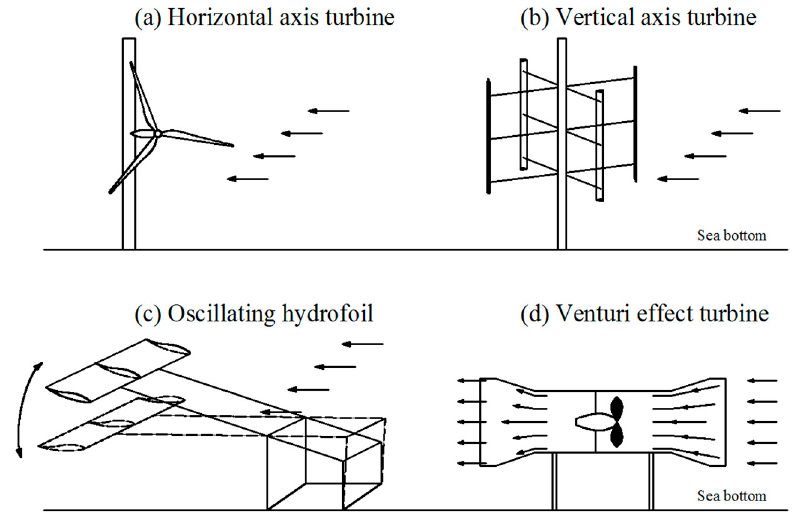
Figure 8. Primary types of tidal and ocean current energy conversion devices.